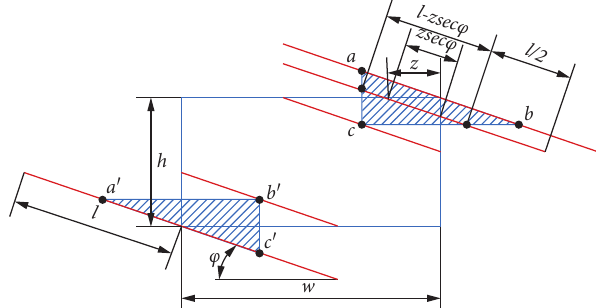
Figure 5: Traces with both ends censored, l ≥ ( h /sin φ ) and φ < tan − 1 ( h / w )